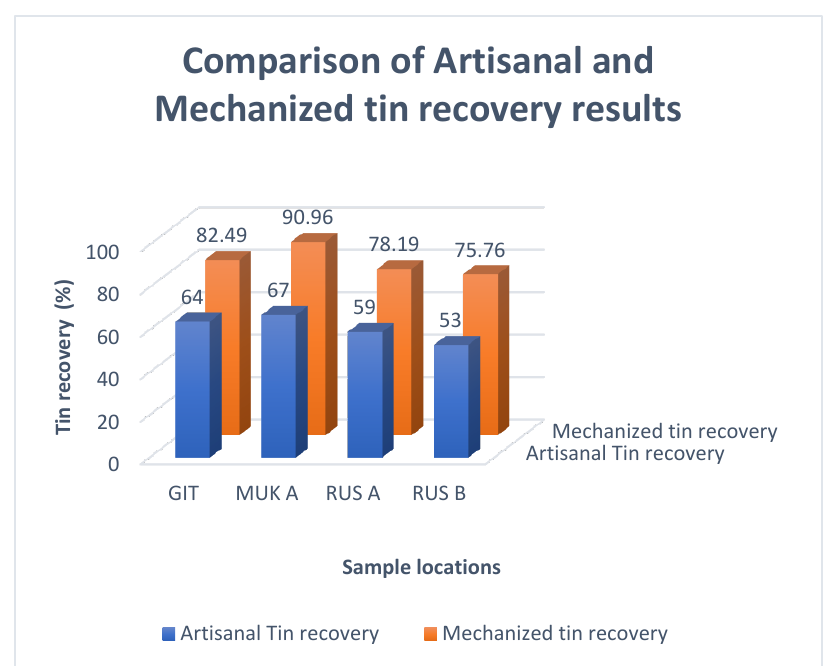
Figure 5. Comparison between the artisanal and mechanized recovery of tin.